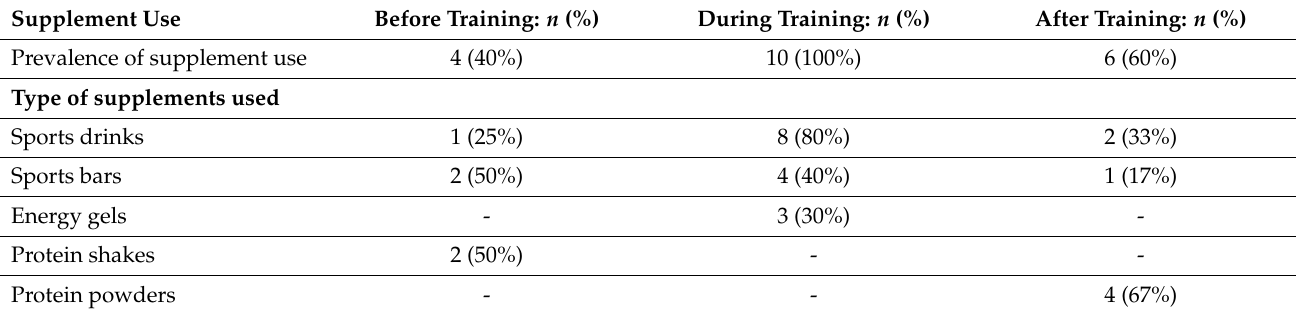
Table 6. Reported supplement intake in relation to training ( n =